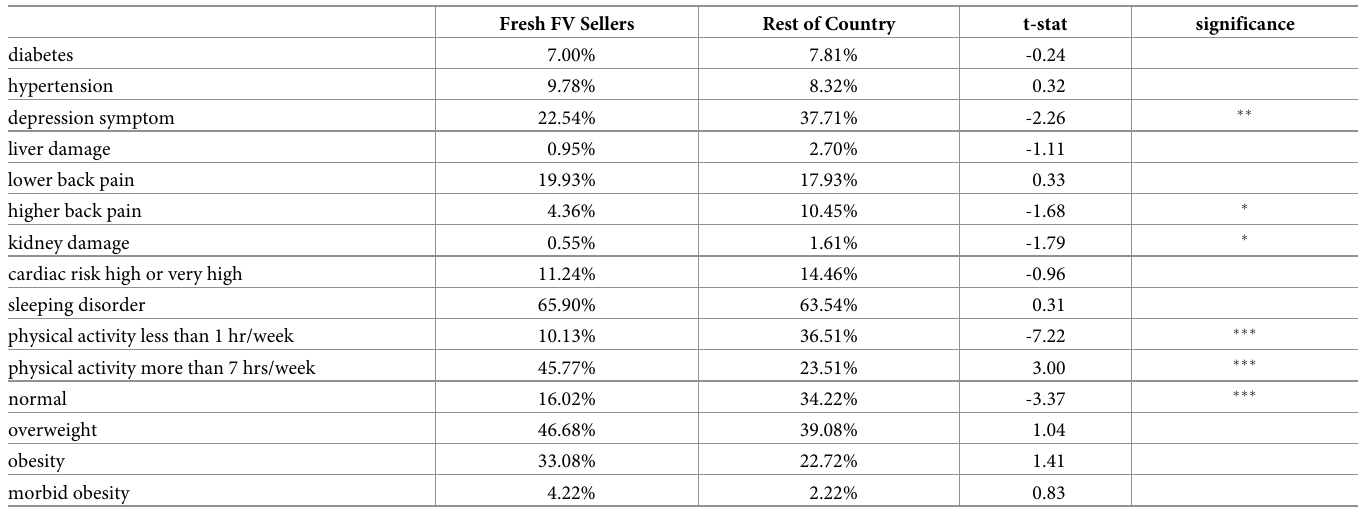
Table 1. Prevalence of diseases by